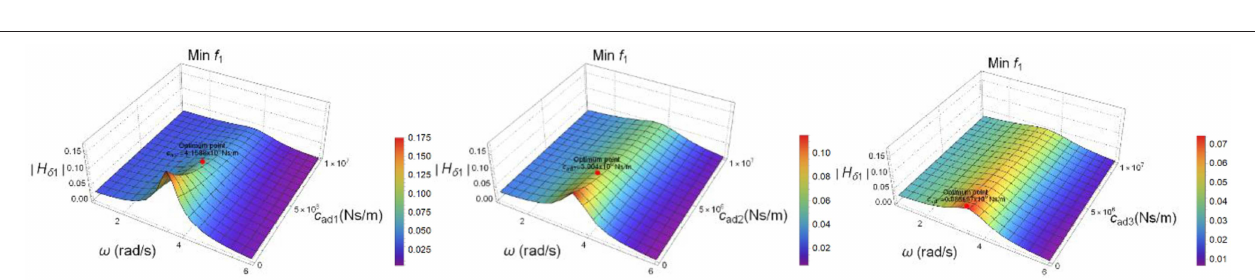
FIGURE 9 | 3D plots of the absolute value of transfer function Frontiers in Built Environment |